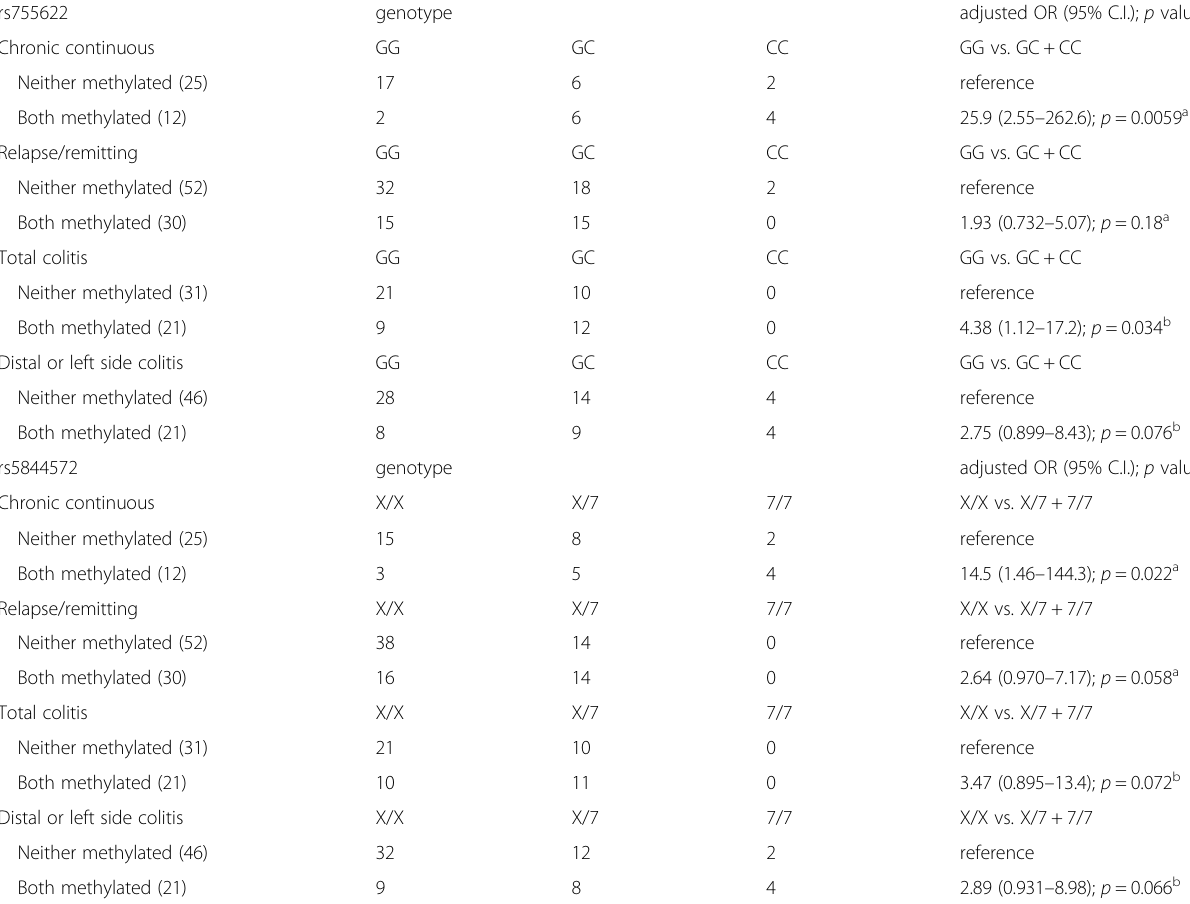
Table 7 Association between MIF polymorphisms and CDKN2A methylation in UC phenotype